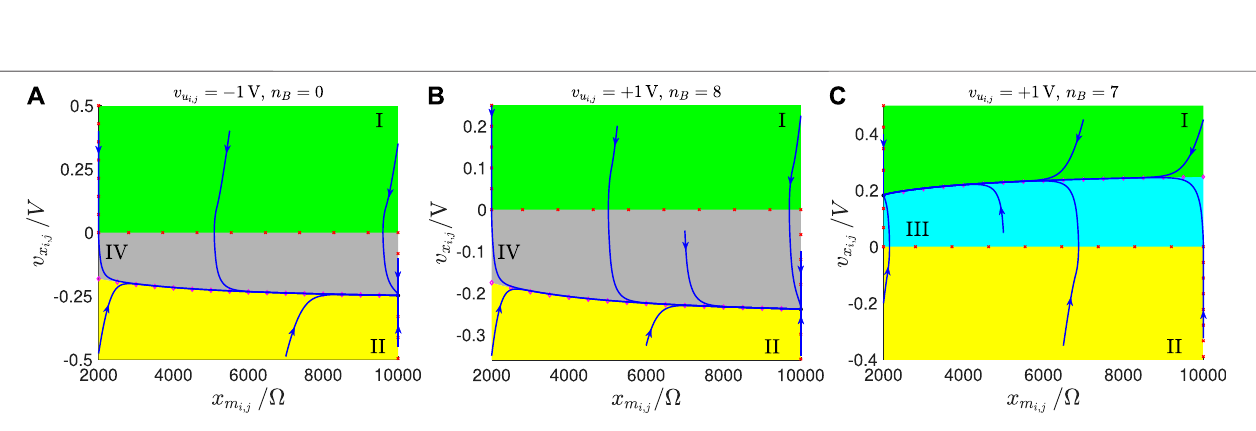
(cid:1) − 1V in the worst-case scenario n (cid:1) 0 of rule 1. (B , C) SDP of a cell C ( i , j ) featuring the input B i , j (cid:1) 7 of rule 3). B